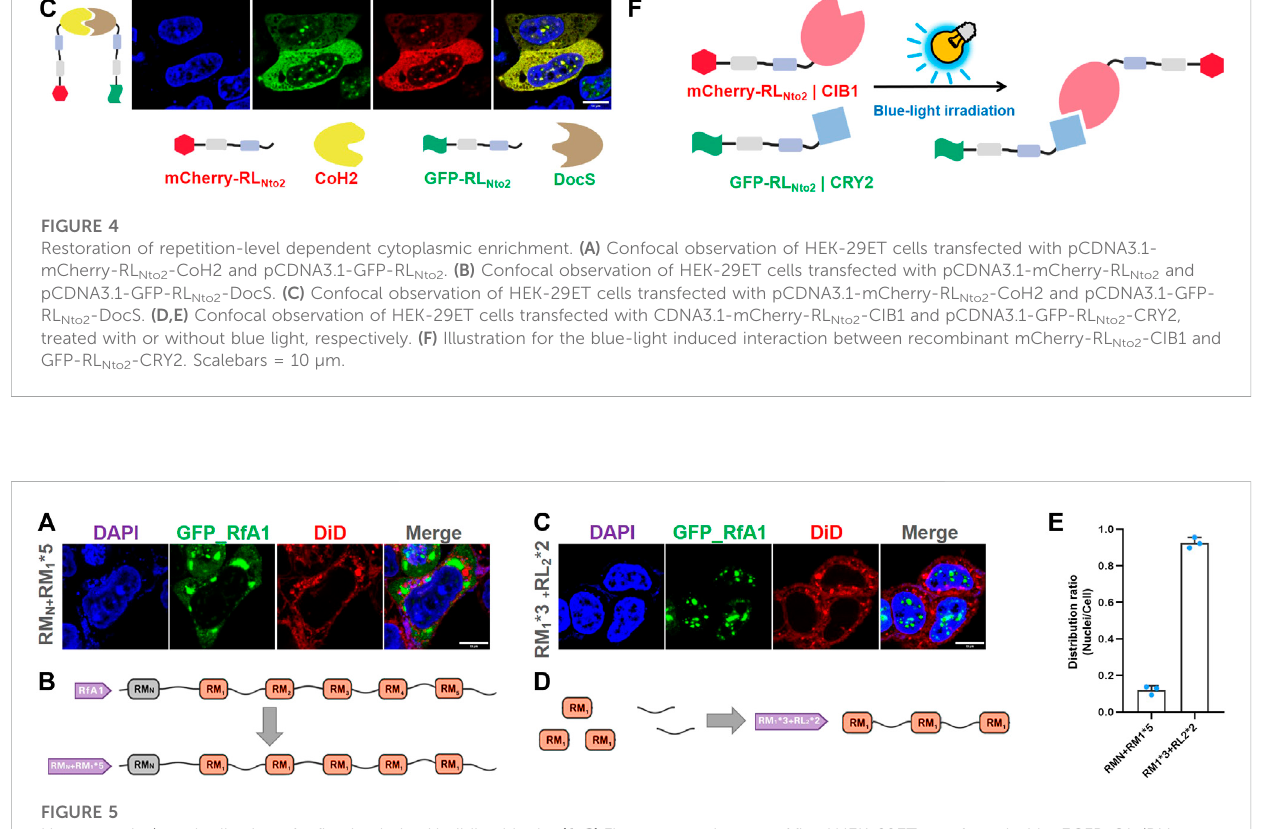
Homogeneity/standardization of re fl ectin-derived building blocks. (A,C) Fluorescence images of fi xed HEK-293T transfected with pEGFP-C1-(RM N + RM 1 *5) and pEGFP-C1-(RM 1 *3 + RL 2 *2), respectively. The nucleus and cytomembrane are stained with DAPI and DiD. (B,D) Schematics of RM N +